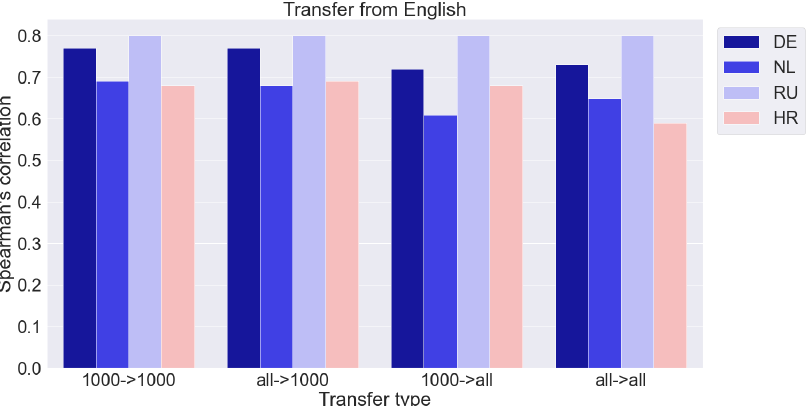
Figure 3. Results of transfer from English dataset to four other languages with respect to dictionary size (‘all’ corresponds to a full dictionary, ‘1000’ corresponds to dictionary with 1000 words).